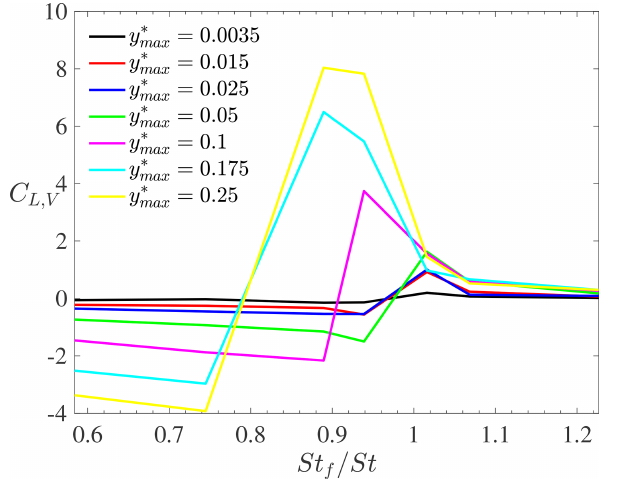
Figure 10. Aerodynamic damping for forced vibrations in the su- percritical turbulent regime with different frequency ratios St f / St and prescribed motion amplitudes y ∗ max